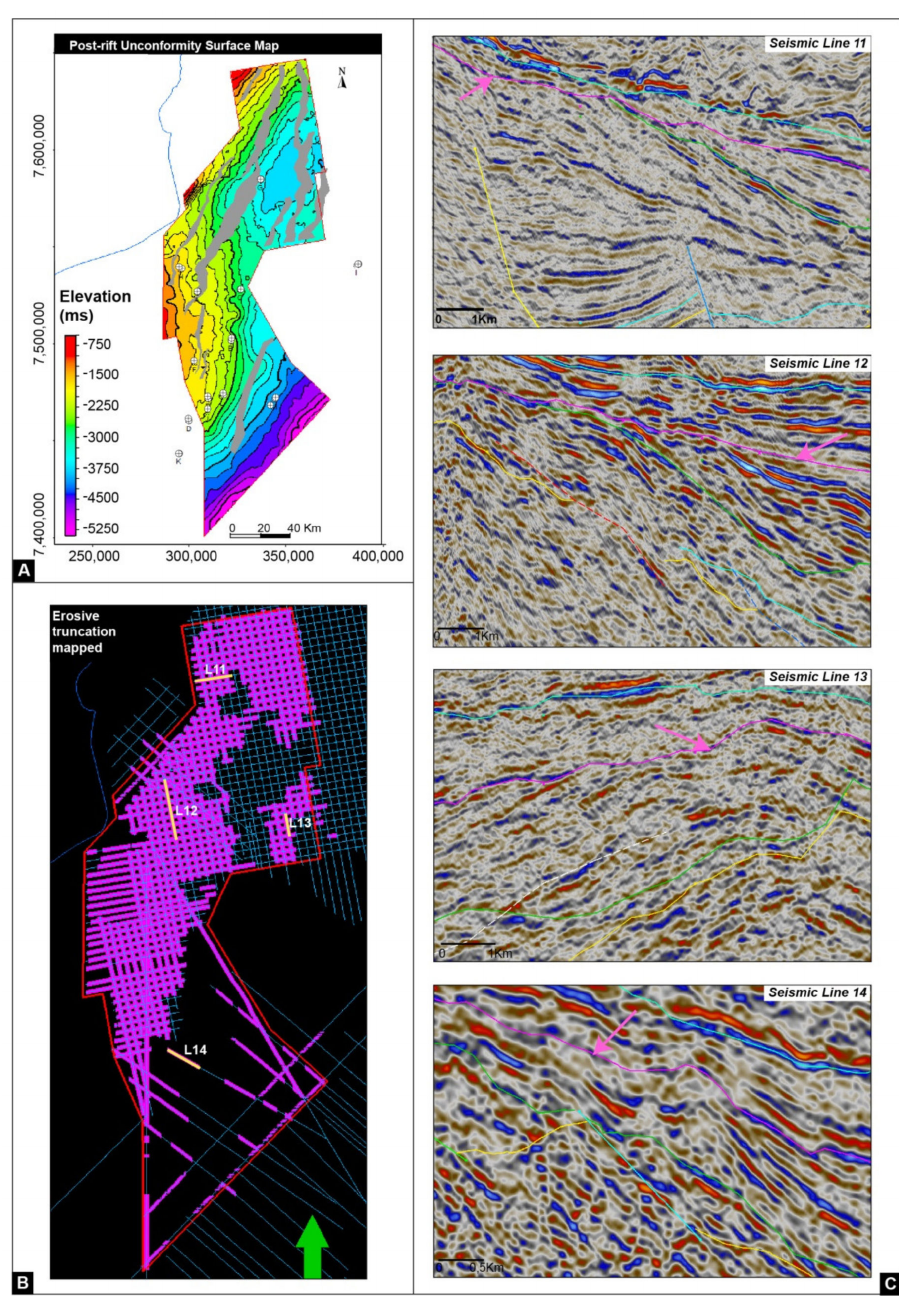
Figure 14. Post-rift unconformity. ( A ) Isochron map (in seismic time) of the post-rift unconfor- mity. ( B ) Occurrence map of erosive truncation of the post-rift unconformity, marked in magenta. ( C ) Examples of erosional truncation recognized along the post-rift